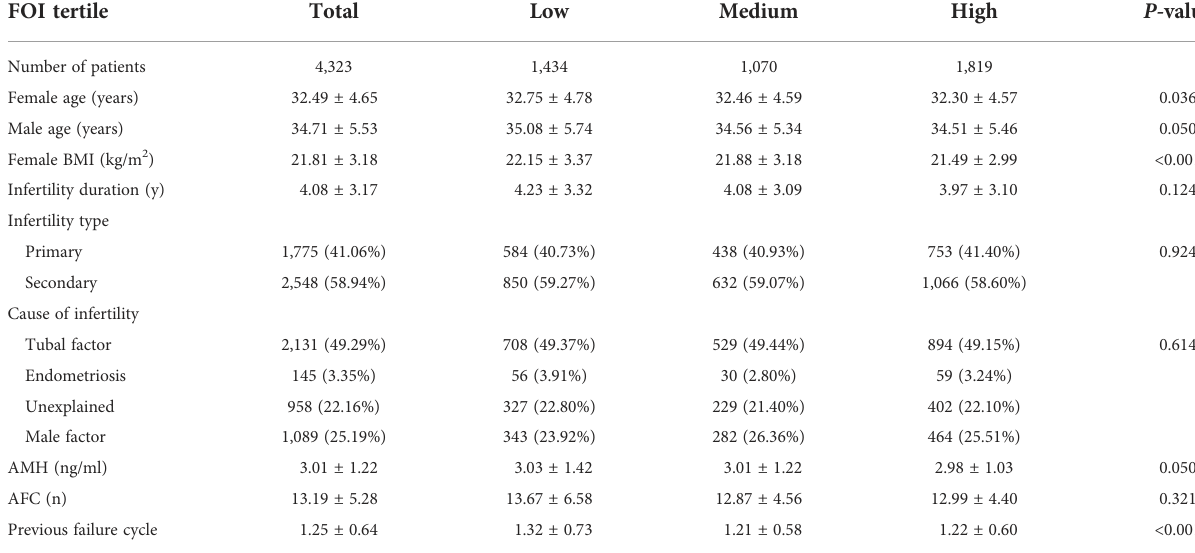
TABLE 1 Baseline characteristics of